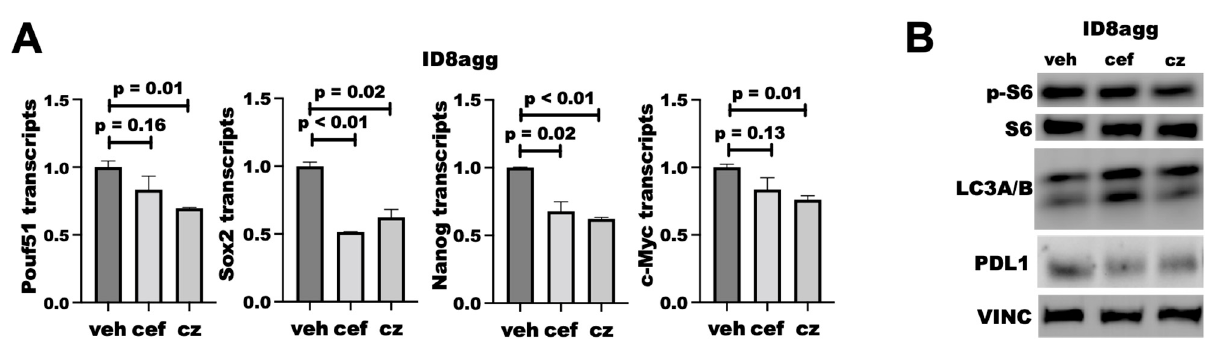
Figure 8. PDDs phenocopy additional genetic tumor-PDL1-depletion effects. ( A ) RT-qPCR for normalized stemness-associated gene expression ( Pouf51 , Sox2 , Nanog , c-Myc) of ID8agg cells treated with DMSO (veh) or 80 µ M cefepime (cef) for 48 h, replenished daily. p values by way of unpaired t test. ( B ) Immunoblot for phospho-S6, total S6, LC3A/B, PDL1, and loading control vinculin (VINC) in ID8agg cells cultured and replenished daily with 80 µ M cefepime (cef) or ceftazidime (cz) daily for two days.